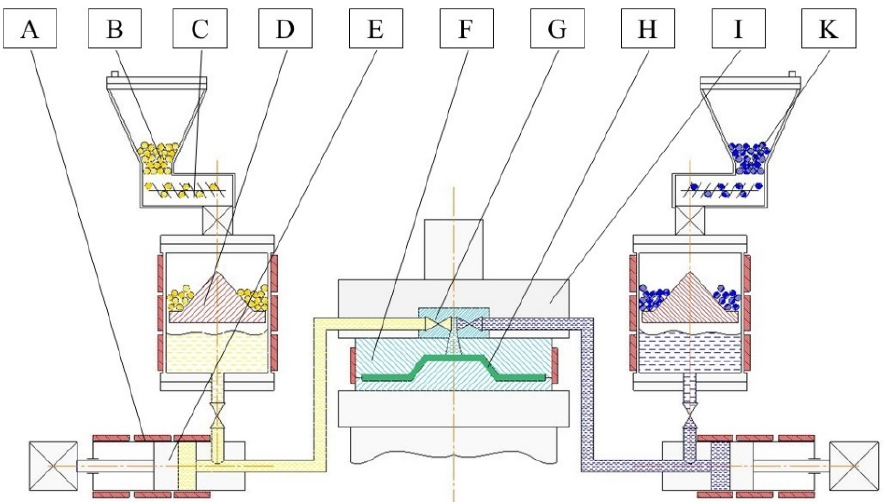
Figure 2. Scheme of the T-RTM process: A: heating; B: ε -caprolactam ( ε -CL) + initiator (masterbatch); C: feeding system; D: melting unit; E: feeding pump; F: mold; G: mixing head; H: product; I: clamping unit; K: ε -CL + activator (masterbatch).